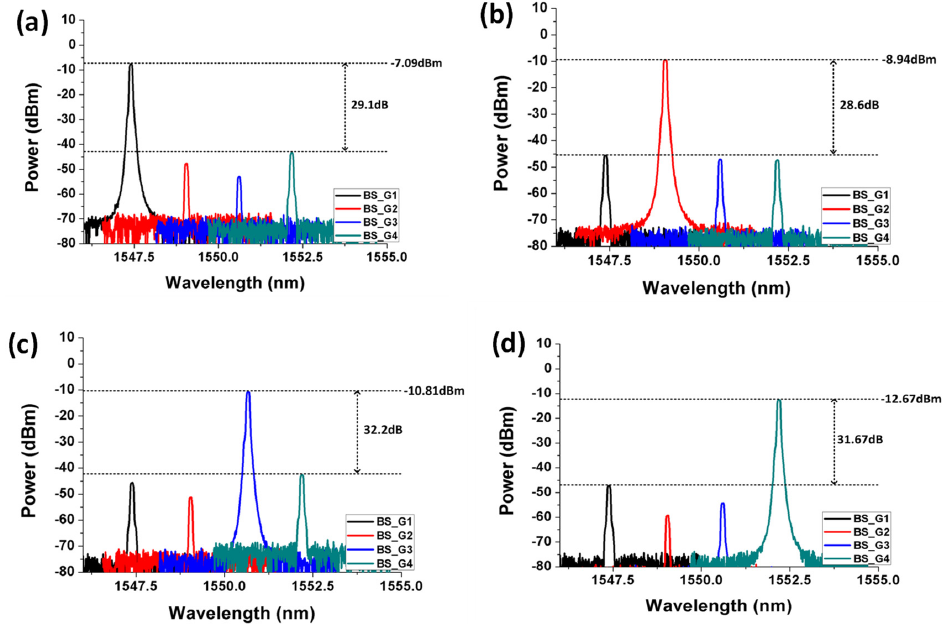
Figure 3. Spectrum measured in front of the PDs of BSs at the ( a ) BS-Group1, ( b ) BS-Group2, ( c ) BS-Group3 and ( d ) BS-Group4.